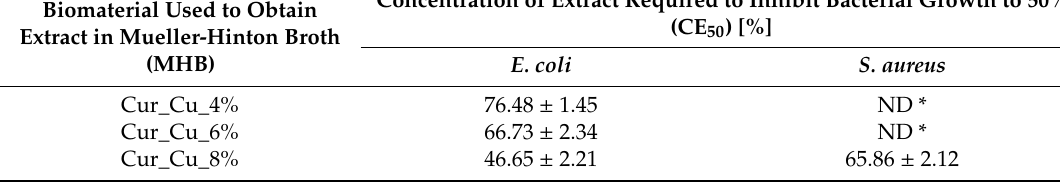
Table 2. The concentration of extract (CE 50 ) obtained from Cur_Cu_4%, Cur_Cu_6%, and Cur_Cu_8% biomaterials, which is required to inhibit E. coli or S. aureus growth to 50%. The CE 50 values were calculated via 4-parameter nonlinear regression analyses, GraphPad Prism 5, version 5.04).